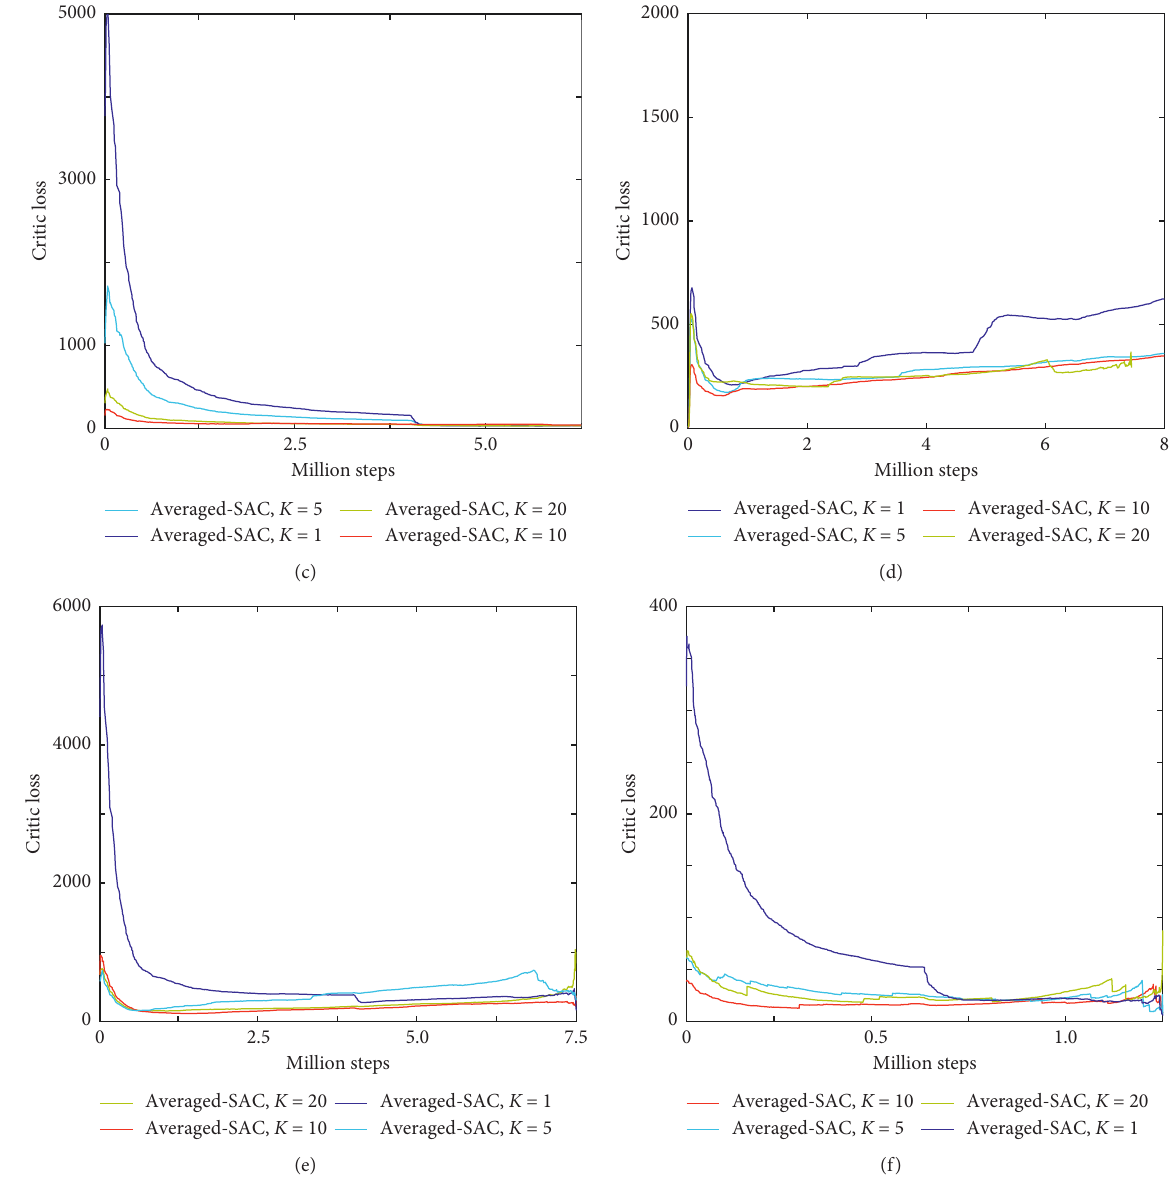
Figure 5: Results of the critic loss of Averaged-SAC with different K values. Analysis of the experimental performance of Averaged-SAC and